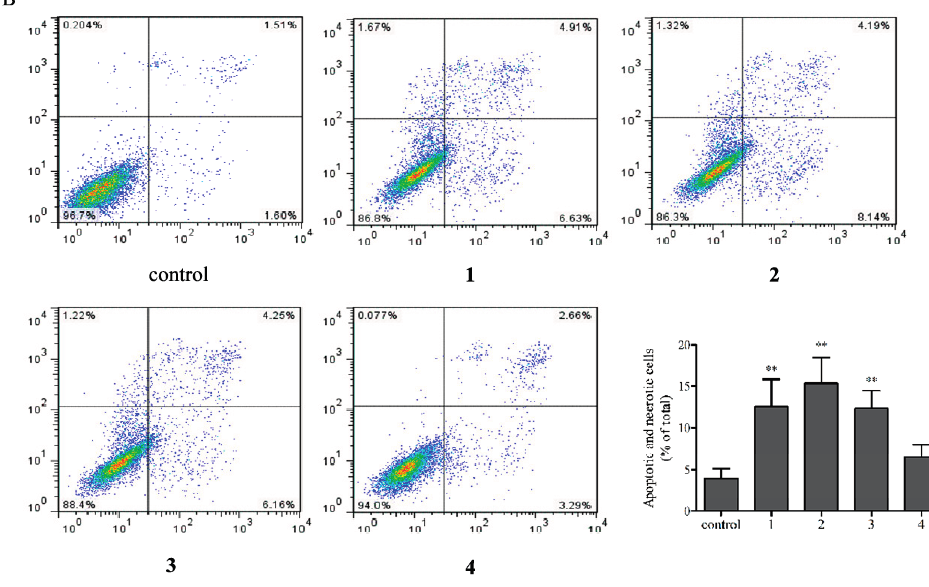
Figure 4. Apoptosis Assessment by Hoechst 33342 Staining and Flow Cytometry. EA.hy926 cells were treated in the absence (control), or in the presence of 50 μ